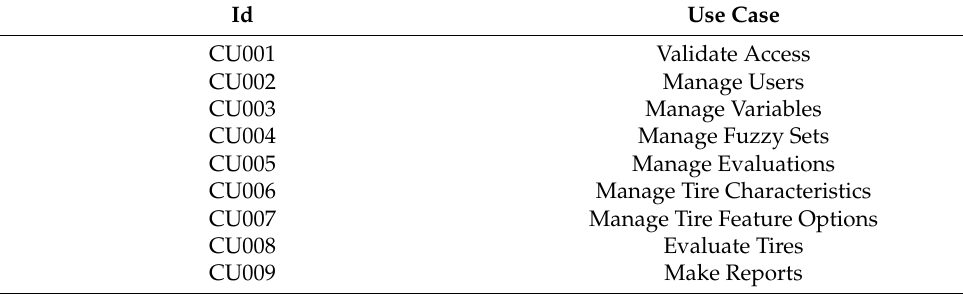
Table 1. Distribution of cases of use of the diagnostic system. Id